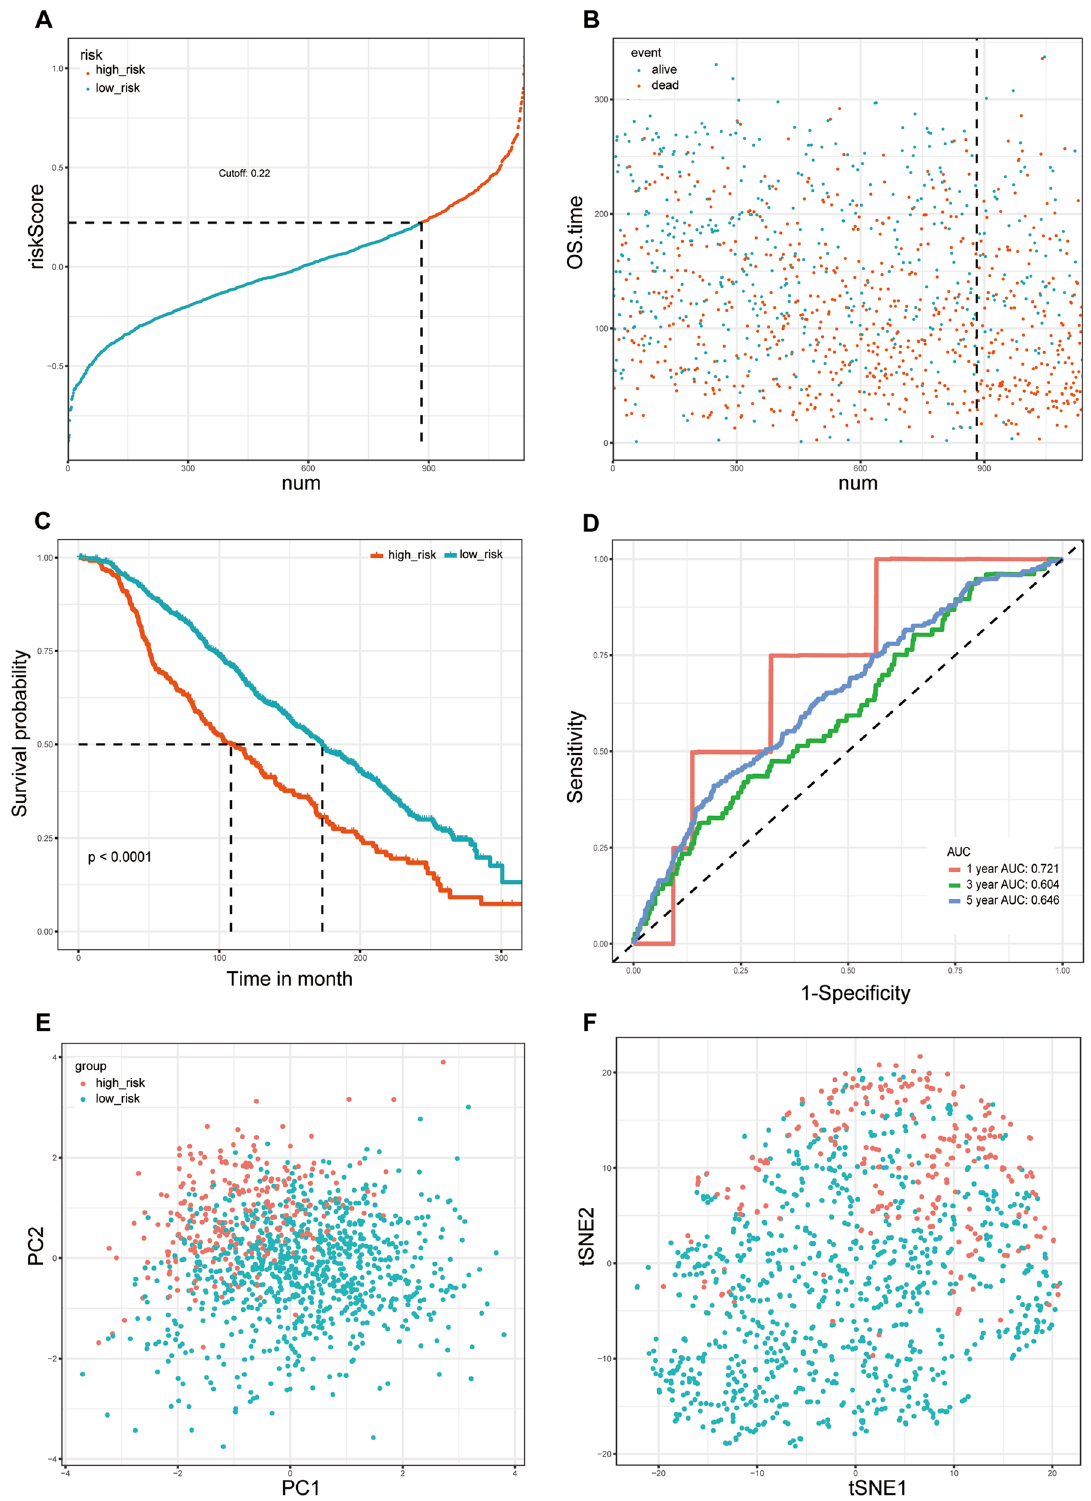
Figure 3. Prognostic analysis of the 10 ferroptosis-related gene signature model in the METABRIC cohort. ( A ) The distribution and median value of the risk score in the METABRIC cohort. ( B ) The distributions of OS status, OS and the risk score in the METABRIC cohort. ( C ) Kaplan–Meier curves for the OS of patients in the high-risk group and low-risk group in the METABRIC cohort. ( D ) The AUCs of time-dependent ROC curves verified the prognostic performance of the risk score in the METABRIC cohort. ( E ) PCA plot of the METABRIC cohort. ( F ) t-SNE analysis of the METABRIC